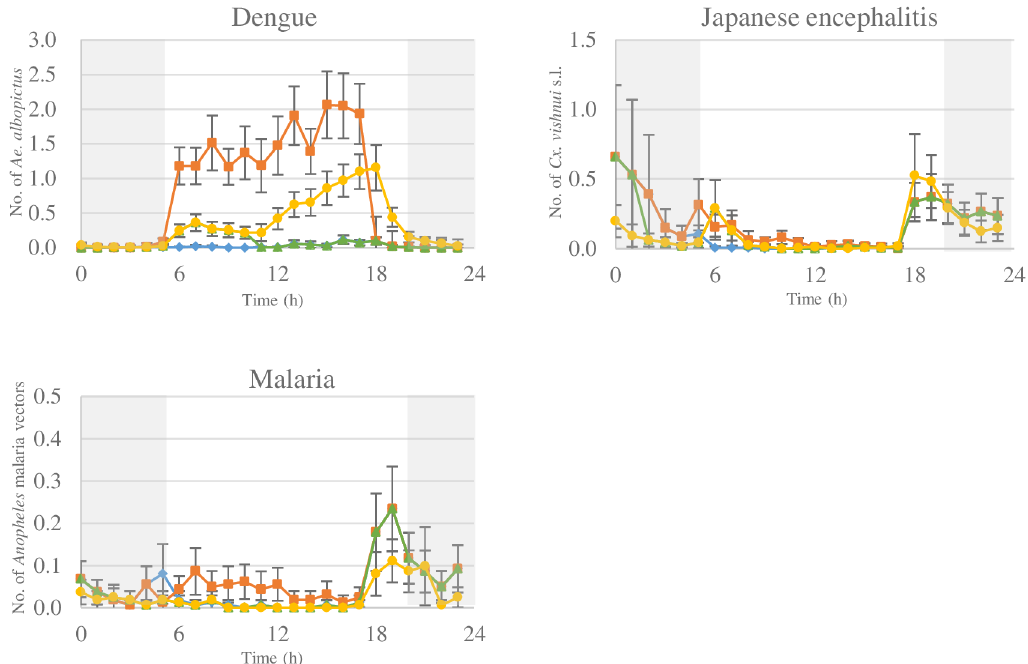
Fig 2. The averagehourly exposure to female Aedes albopictus (dengue vector), Culex vishnui s.l. (Japanese encephalitis vector), and Anopheles malaria vectorsfor the different typologies, ( ━■━ villagers that visit the forest during the day from 5.00 to 17.00 h, ━▲━ villagers that work in the rubber plantations, ━●━ migrant workers that live and work in the rubber plantations, ━♦━ villager that stays in the village) with the possible use of bed nets indicated from 20.00 h to 5.00 h with █ . All including95% confidenceinterval. https://doi.org/10.1371/journal.pntd.0005802.g002 rubber plantations. Here the risk of dengue vector exposure is 16 fold higher than staying in the village (Fig 2, Table 3). However, rubber workers living in the plantations are exposed to similar number of Cx . vishnui s.l. mosquitoes and slightly fewer malaria vectors than those